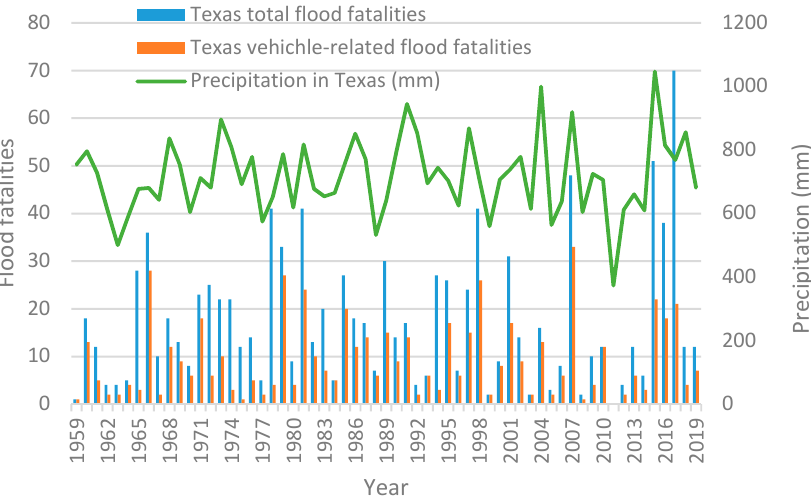
Figure 2. Numbers of annual flood fatalities and vehicle-related flood fatalities in Texas, 1959–2019.